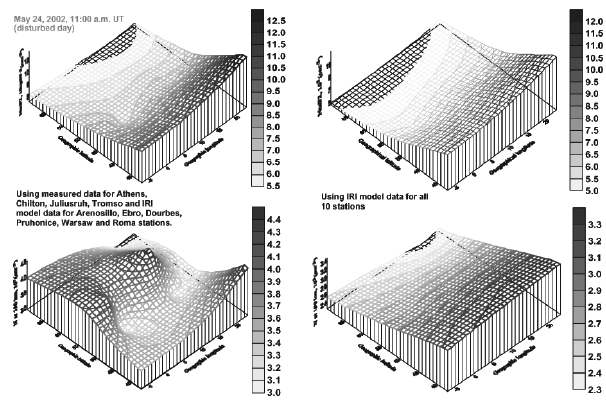
Fig. 3.10b. Plots of hmF 2 and electron density and 190 km across the European area, produced by combinations of the IRI-2000 model and observations. The top pair of graphs shows NmF 2 and the bottom pair show the 190 km electron density derived from values at Athens, Chilton, Juliusruh, Tromsø, El Arenosillo, Dourbes, Ebro, Pruhon- ice, Roma and Warsaw; the left-hand pair uses observed data for the first four stations and IRI data for the other six; the right-hand pair uses IRI-2000 data for all ten